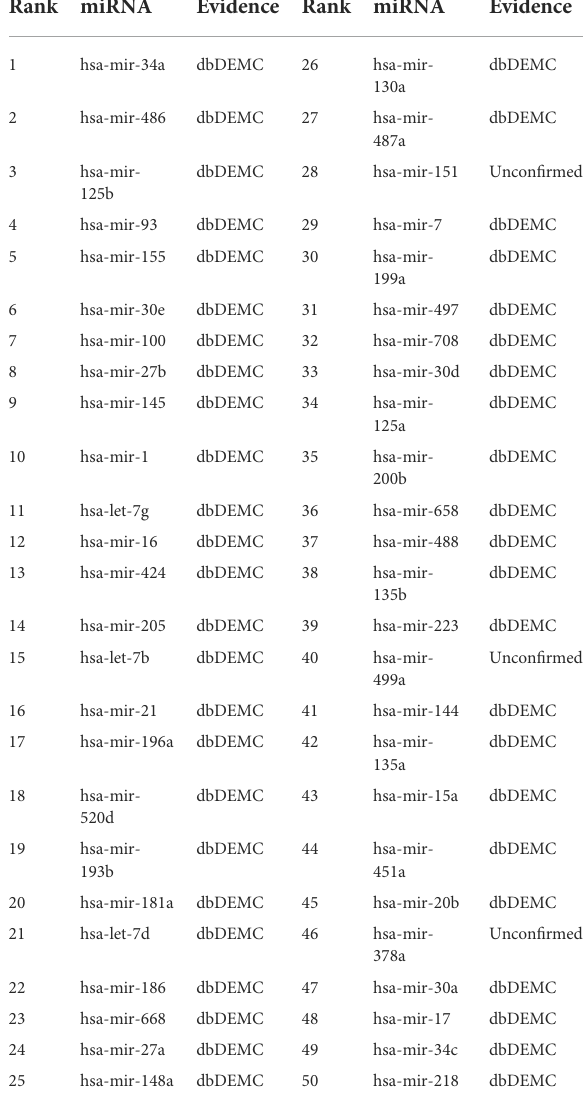
TABLE 6 Top 50 miRNAs related to lung neoplasms predicted by MKFGCNII. Rank miRNA Evidence Rank miRNA